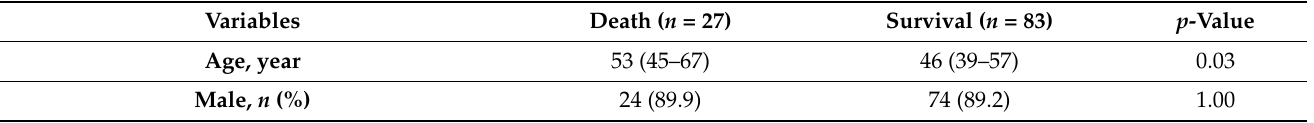
Table 3. Comparisons of baseline characteristics, laboratory data, and treatments during ICU stay between survival and death